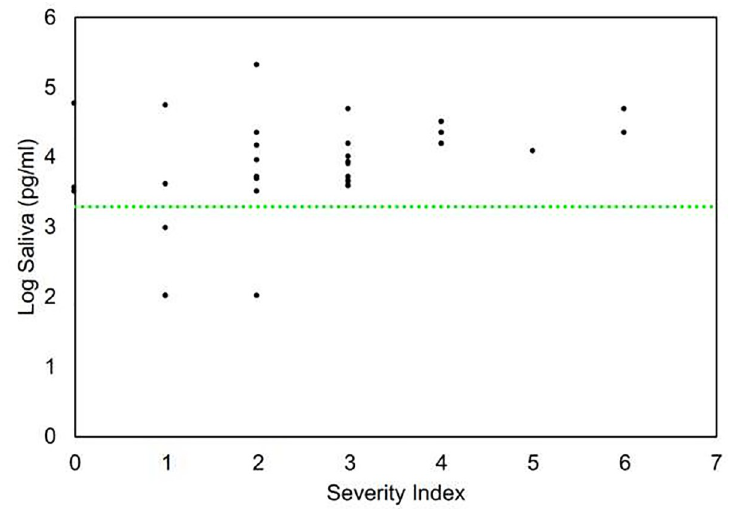
Fig 8. Clinical severity index and anti-Spike S1 IgG level in